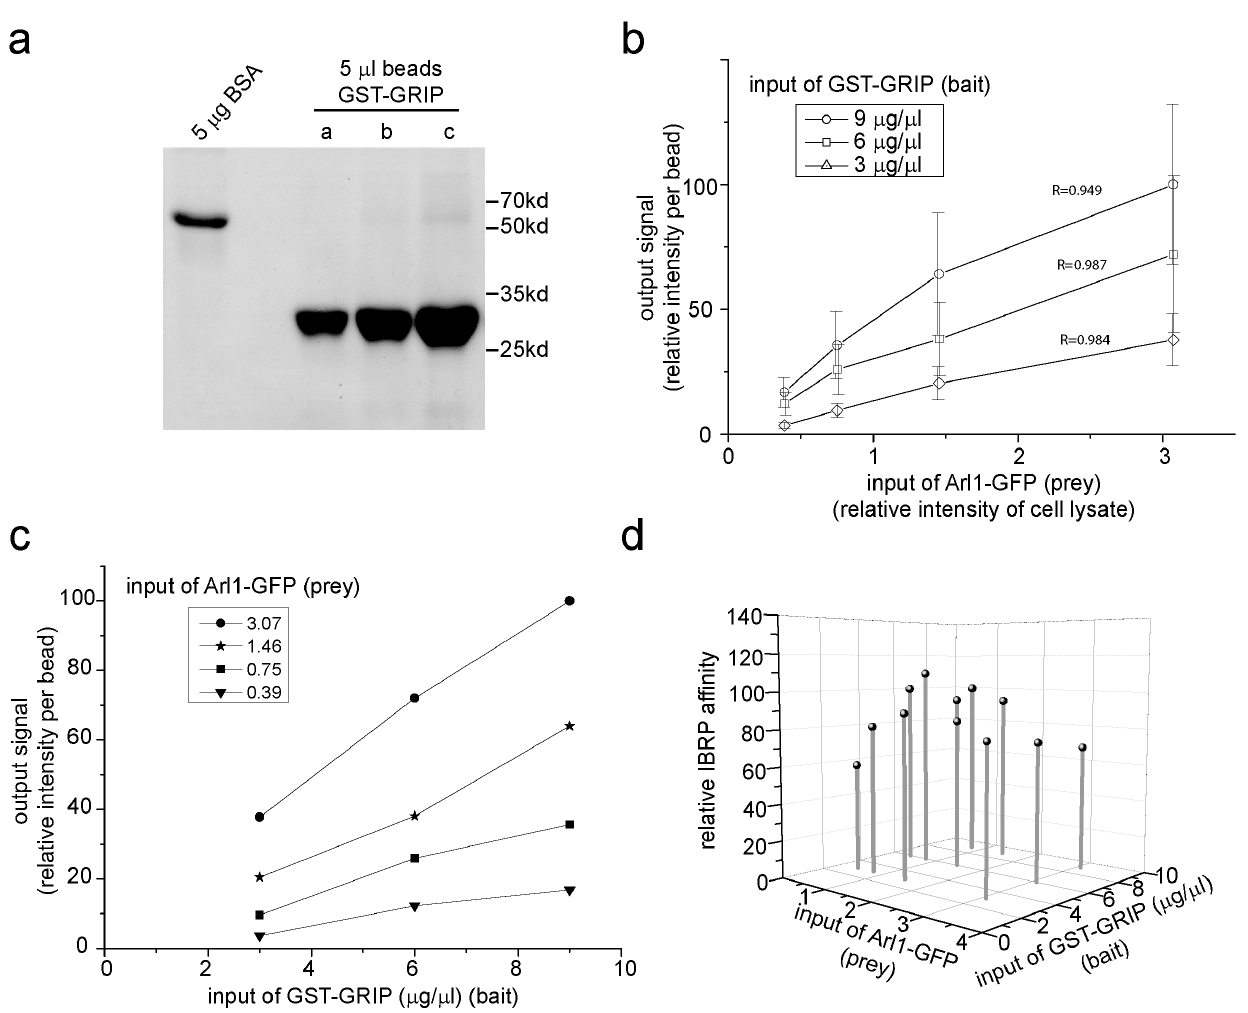
Figure 3. Characterizing the input and output relationship of IBRP assay using Arl1/GRIP interaction. (a) Quantification of the input of GST-GRIP used in this study by Coomassie staining. GST-GRIP bead slurry in preparation a, b and c was semi-quantified as 3, 6 and 9 m g/ m l, respectively. BSA, bovine serum albumin. (b-d) The assay was conducted using a combination of various inputs of GST-GRIP (bait) and Arl1-GFP (prey). The number of beads quantified (n) for each data point is in between 95 and 141. The same set of data are plotted in three different formats to illustrate the input and output relationship. (b) The linear relationship between the output signal (relative intensity per bead) and the input of Arl1- GFP (relative intensity of the cell lysate). R indicates the R-square values for linear fitting. Error bars represent standard deviations. (c) The linear relationship between the output signal (relative intensity per bead) and the input of GST-GRIP ( m g/ m l). (d) The relative IBRP affinity, input of Arl1-GFP and input of GST-GRIP are plotted in a 3D graph. The mean 6 standard deviation of the relative IBRP affinity is 90 6 10